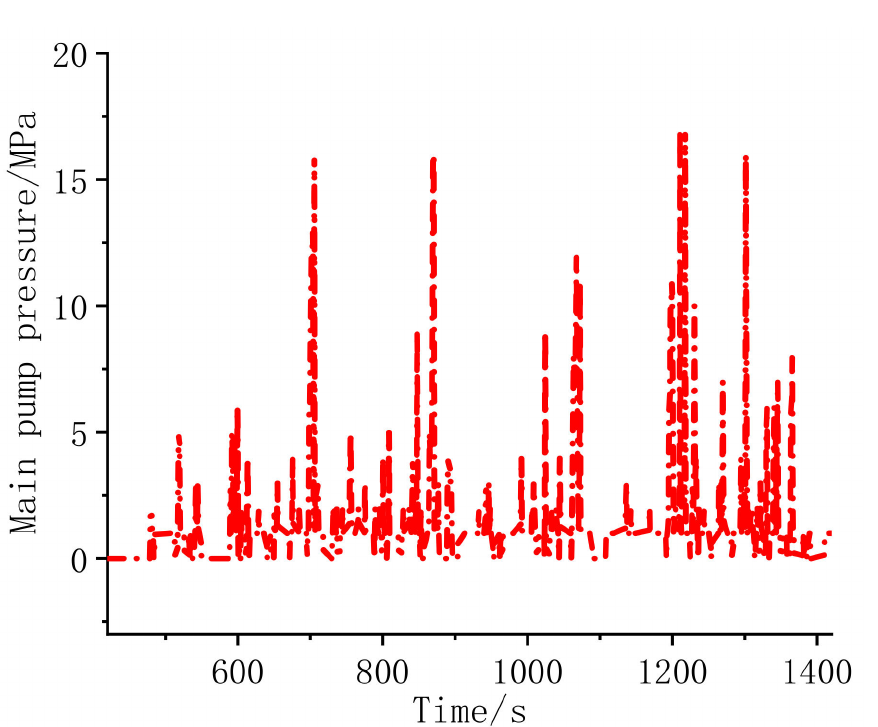
Figure 2. Pressure curve of the main pump in the